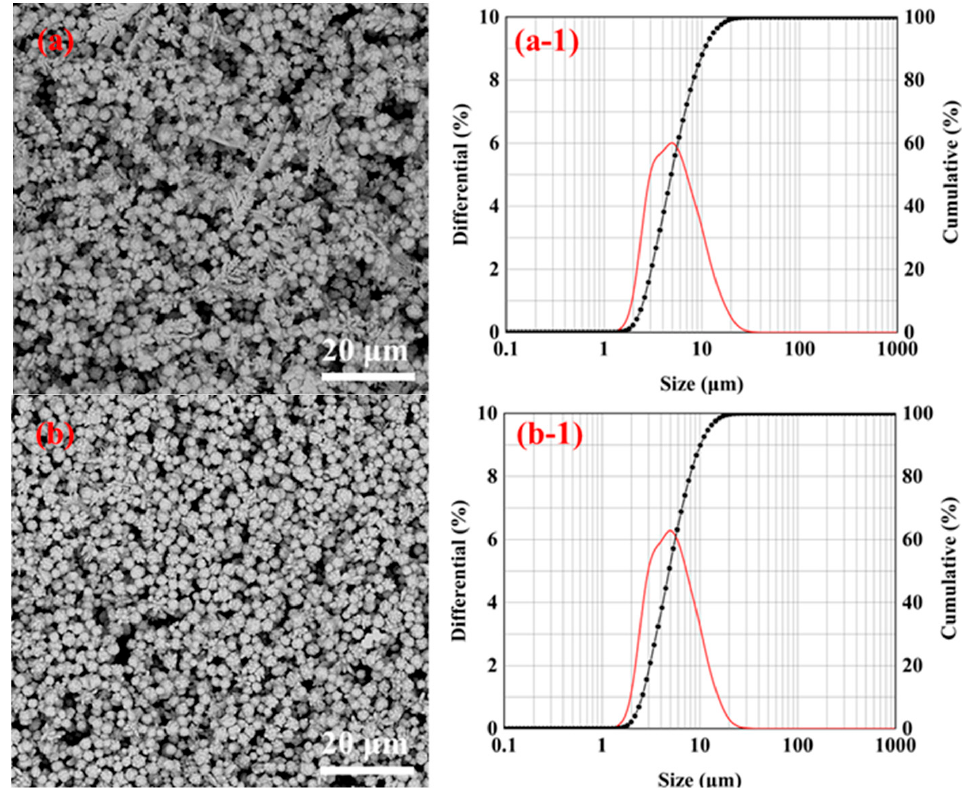
Figure 7. SEM images and particle size distribution of silver powders prepared under different flow rates by adding 2% gelatin. ( a ) 50 mL/min; ( b ) 75 mL/min; and ( c ) 100